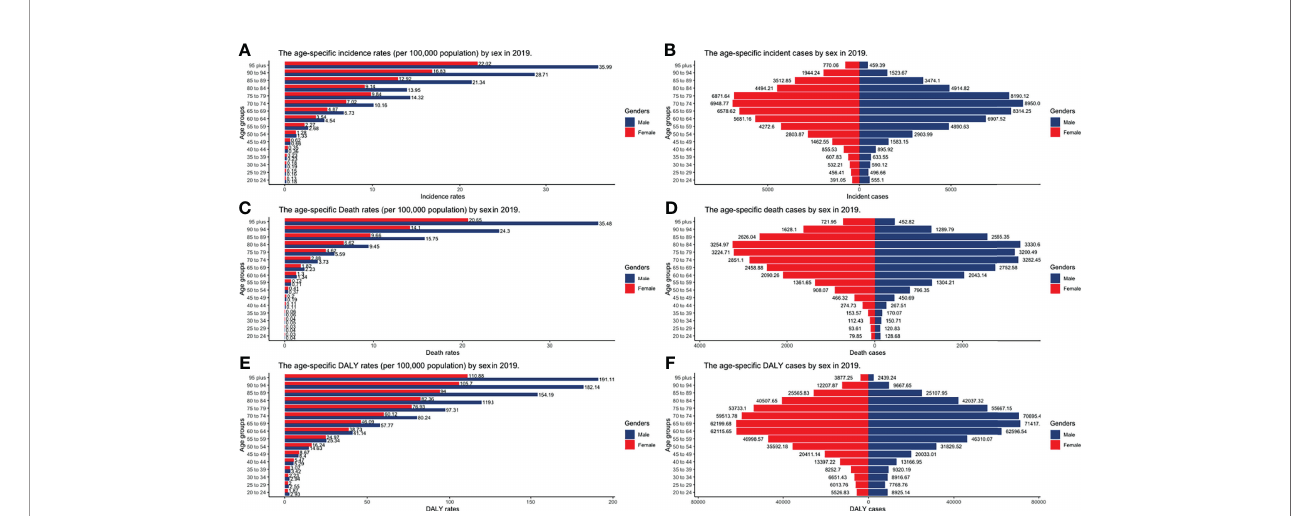
FIGURE 7 | The burden of incidence, deaths, and DALY by gender and age groups in 2019. (A) Incident cases; (B) Incidence rates; (C) death cases; (D) death rates; (E) DALY rates; (F) DALY cases (DALY, disability-adjusted life